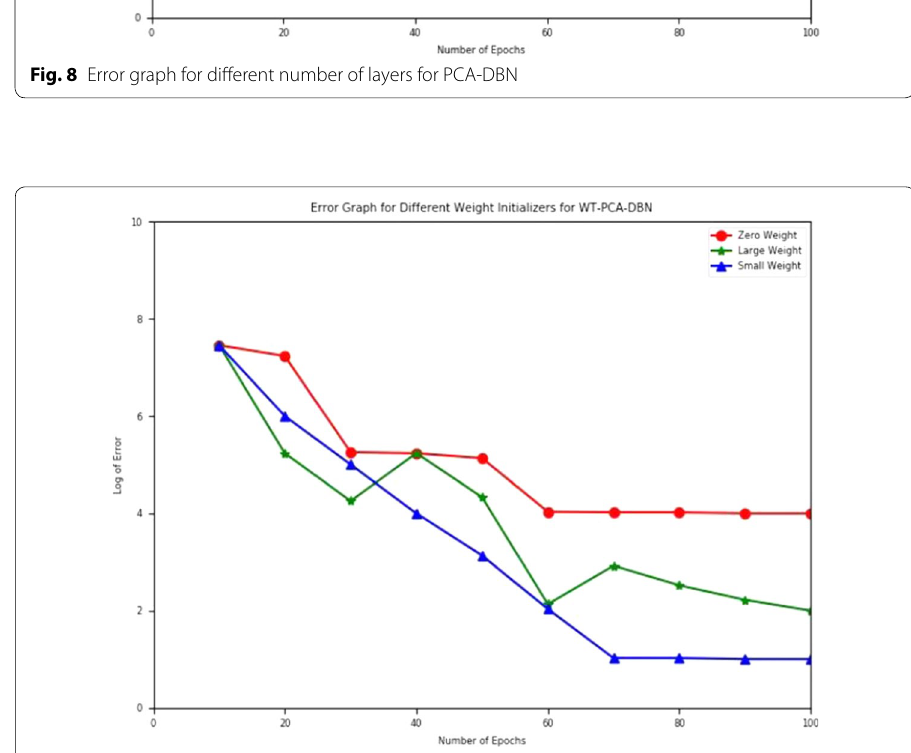
Fig. 9 Error graph for different number of layers for proposed